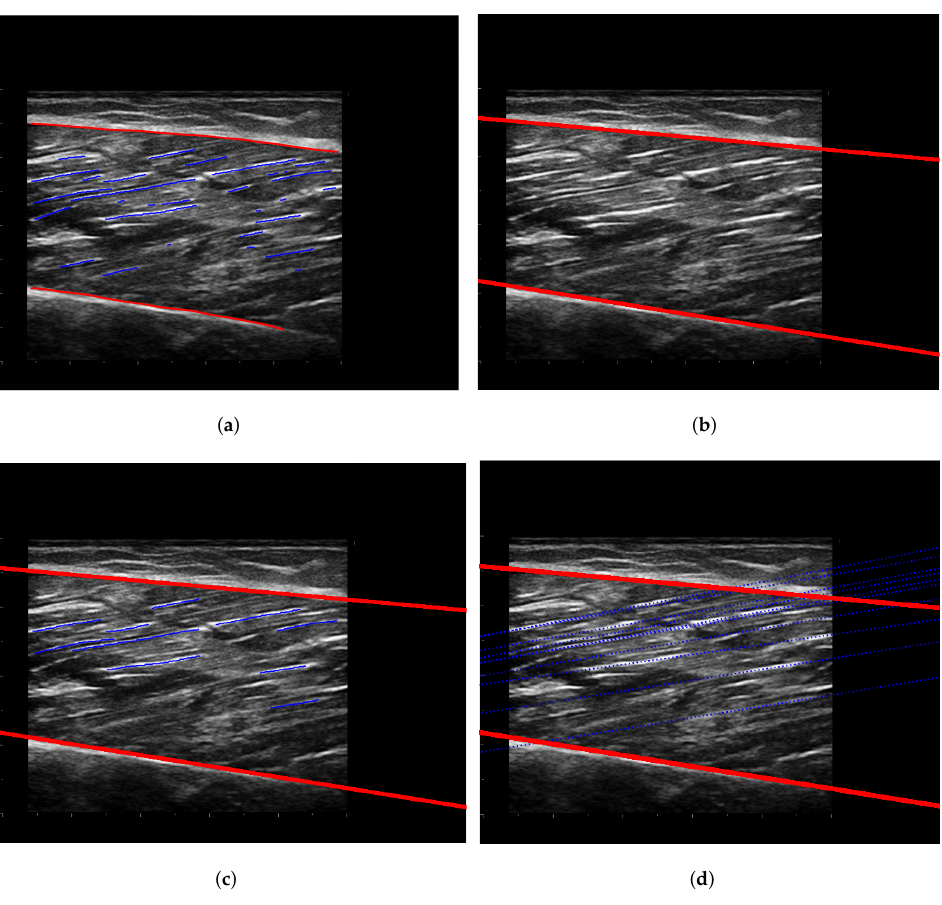
Figure 7. The post-processing steps for outputs. The blue line represents the fascicles; the red line represents the edge of the deep and superficial aponeuroses. ( a ) Contour extraction. ( b ) Linear fitting of aponeuroses. ( c ) Linear fitting and screening of fascicles. ( d ) Calculation of intersection.